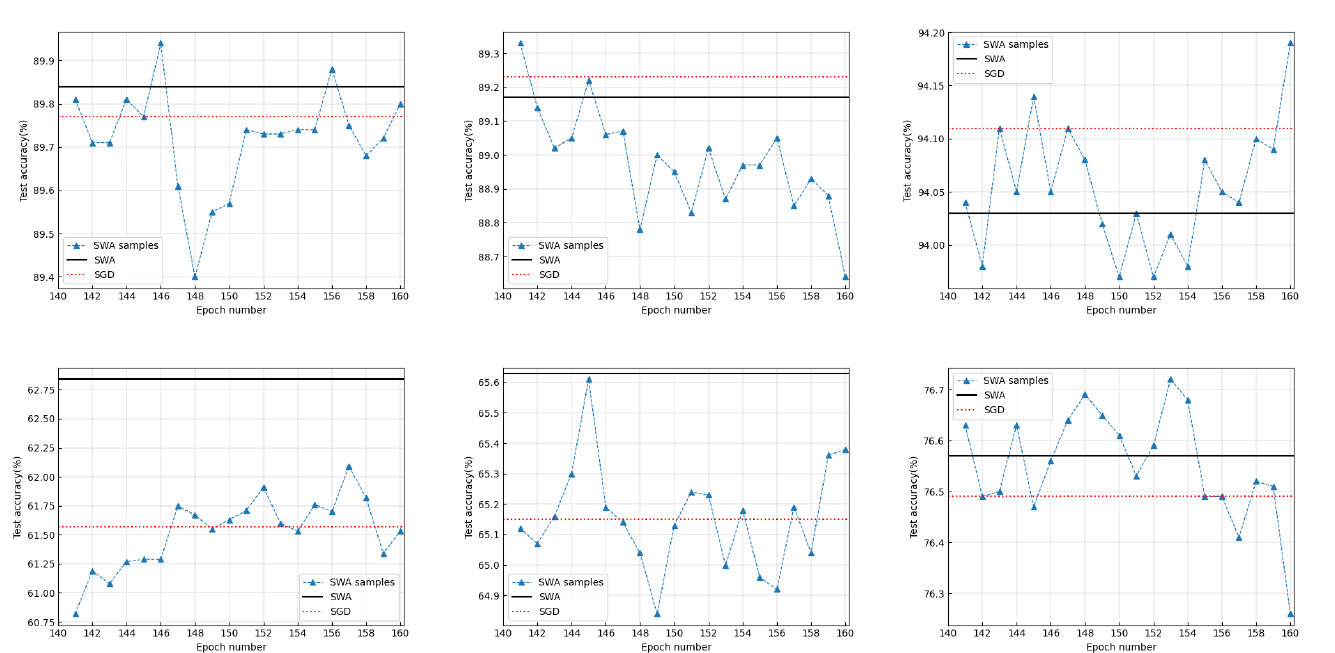
Figure 1. Ablation study of the CHC learning-rate schedule and the weight-averaging operation for DNNs that converge well. The legend “SGD" denotes the test accuracy value associated with the NN weight as provided by the backbone SGD at the time point when SWA was started. The legend “SWA samples” denotes test accuracy values associated with NN weights sampled during the SWA procedure. The legend “SWA” denotes the test accuracy value associated with the mean of NN weights sampled during the SWA procedure. The sub-figures in the left/middle/right columns correspond to VGG16/PreResNet-164/WideResNet-28-10. The sub-figures in the top/bottom rows correspond to dataset